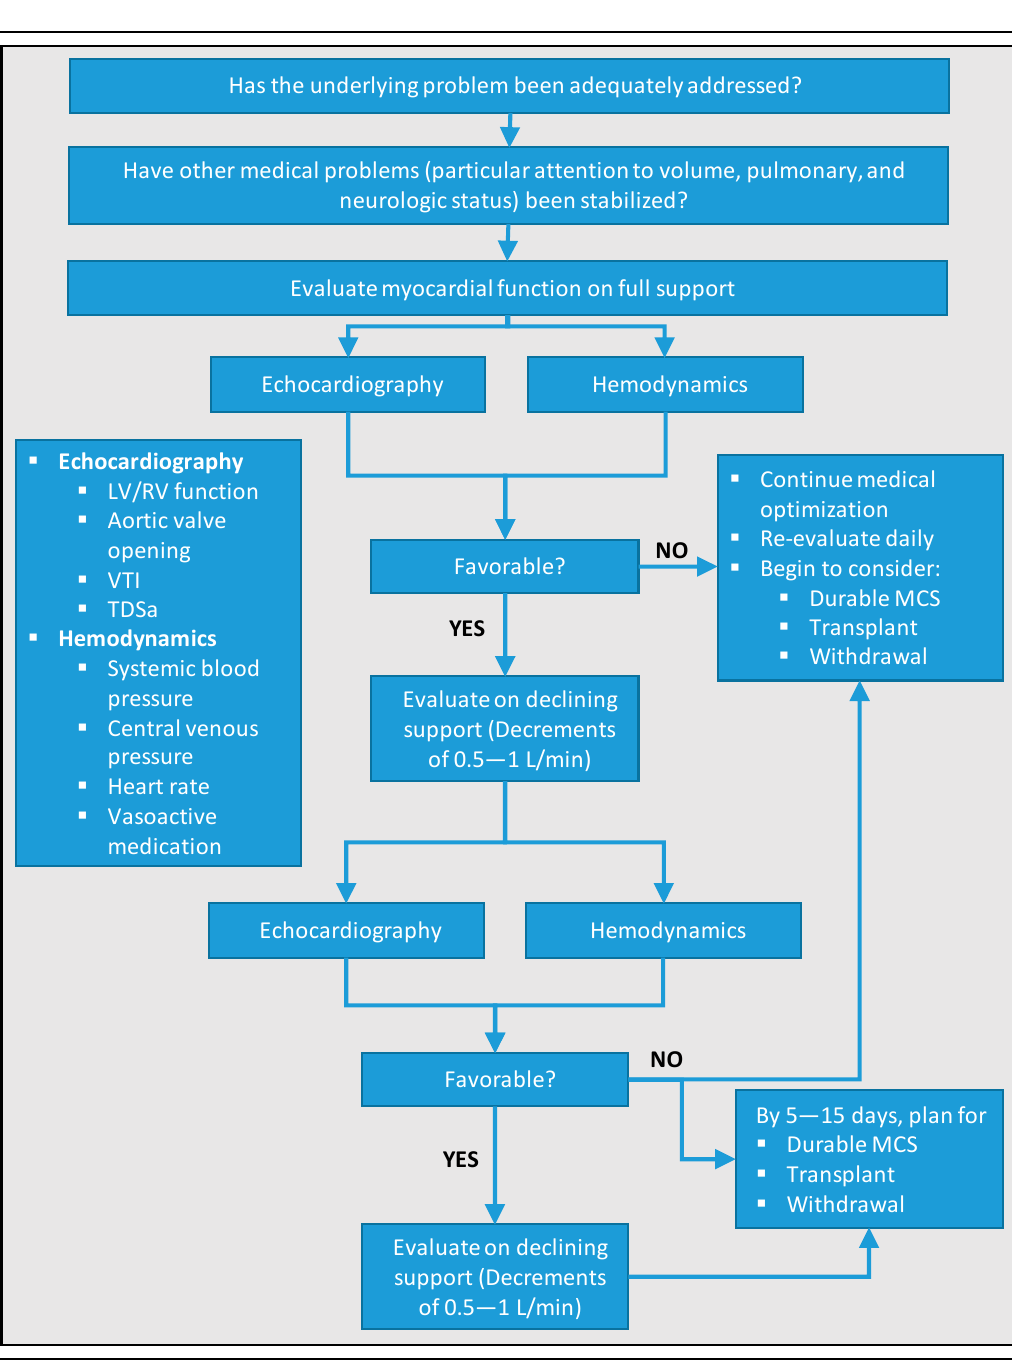
Figure 3. Standardized protocol for weaning from VA-ECMO according to Eckman et al. [10]. LV, left ventricle; RV, right ventricle; VTI, velocity-time integral; TDSa, tissue Doppler lateral mitral annulus peak systolic velocity; MCS, mechanical circulatory support.